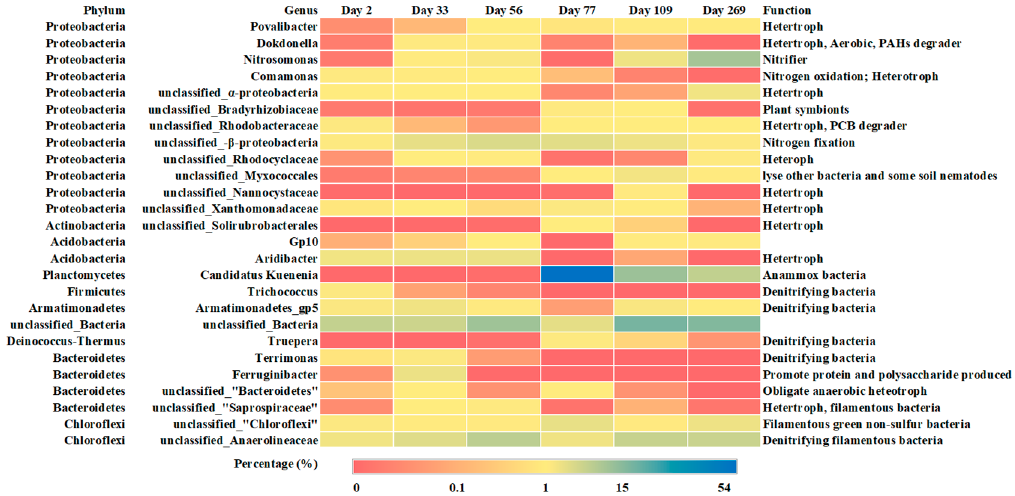
Figure 5. Heatmap of the core genera in the sludge samples on various days.